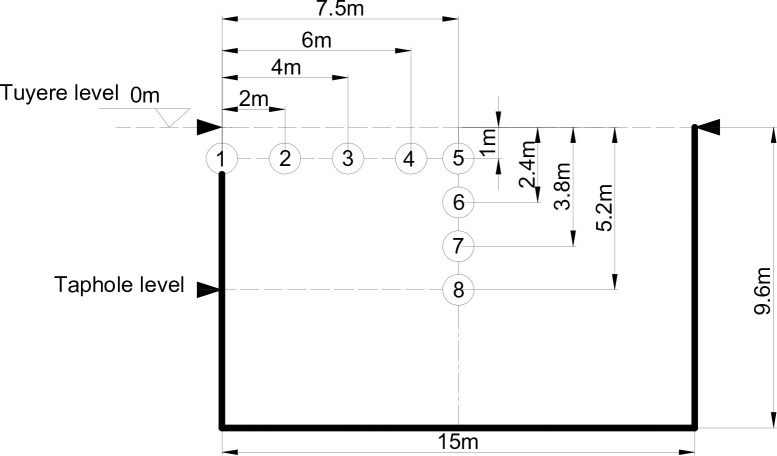
Sampling locations.